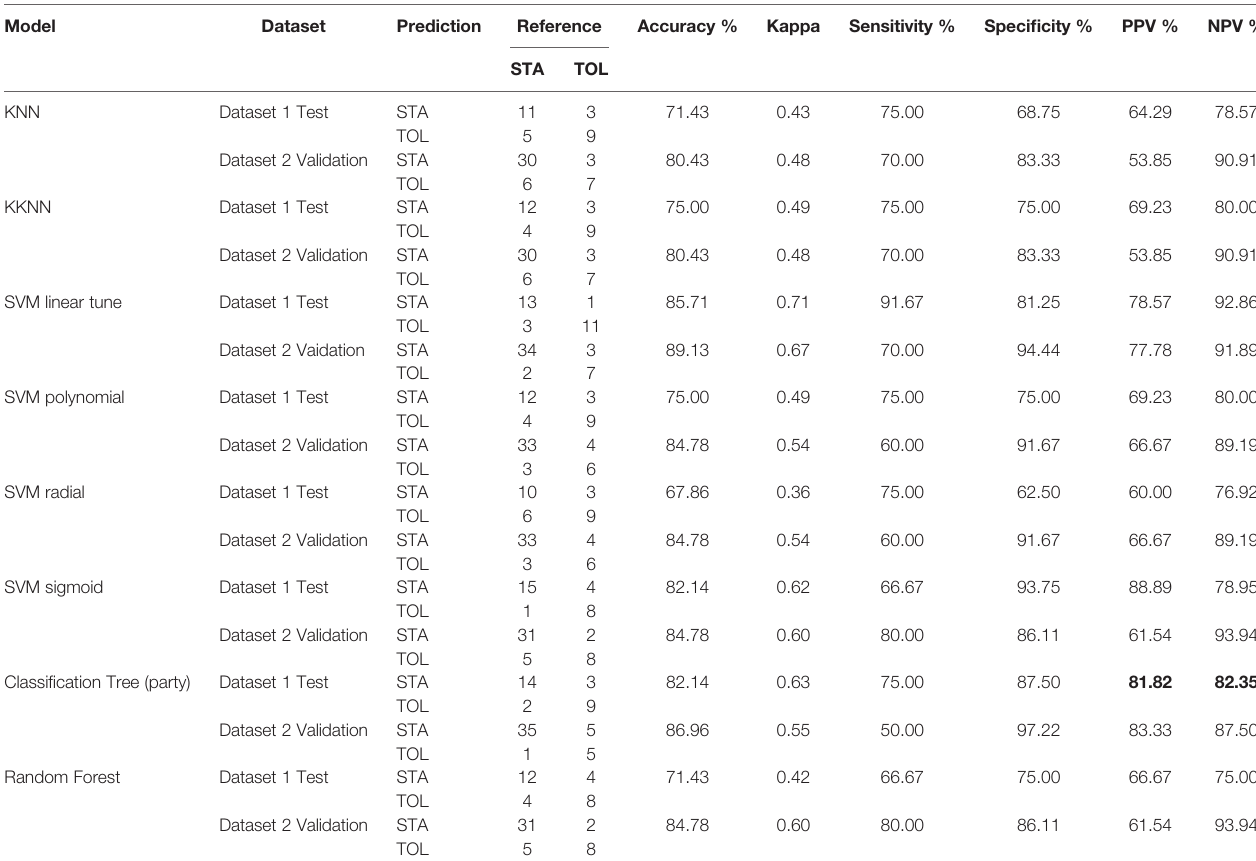
TABLE 1 | Confusion Matrix and Statistics using KNN, KKNN, SVM, Classi fi cation Tree, and Random Forest. Model